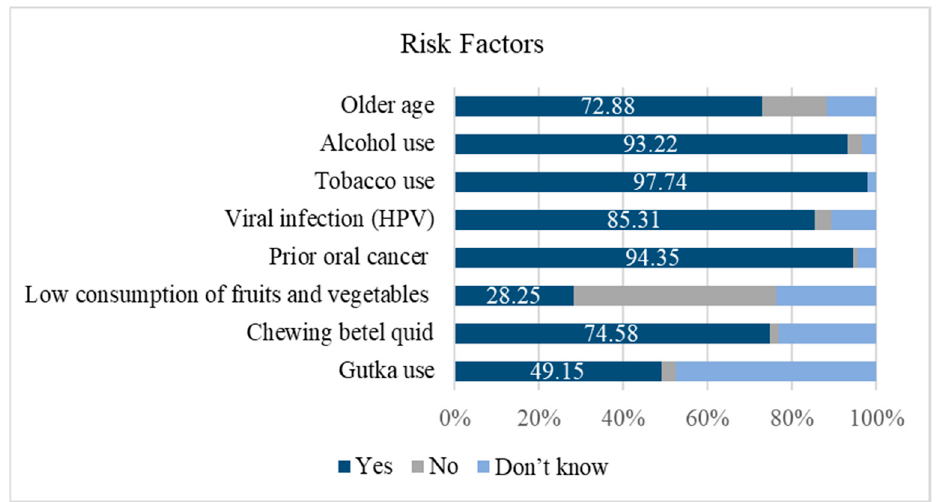
Figure 2. Percentage of dentists that correctly identified the listed risk factors for oral cancer ( n = 177).